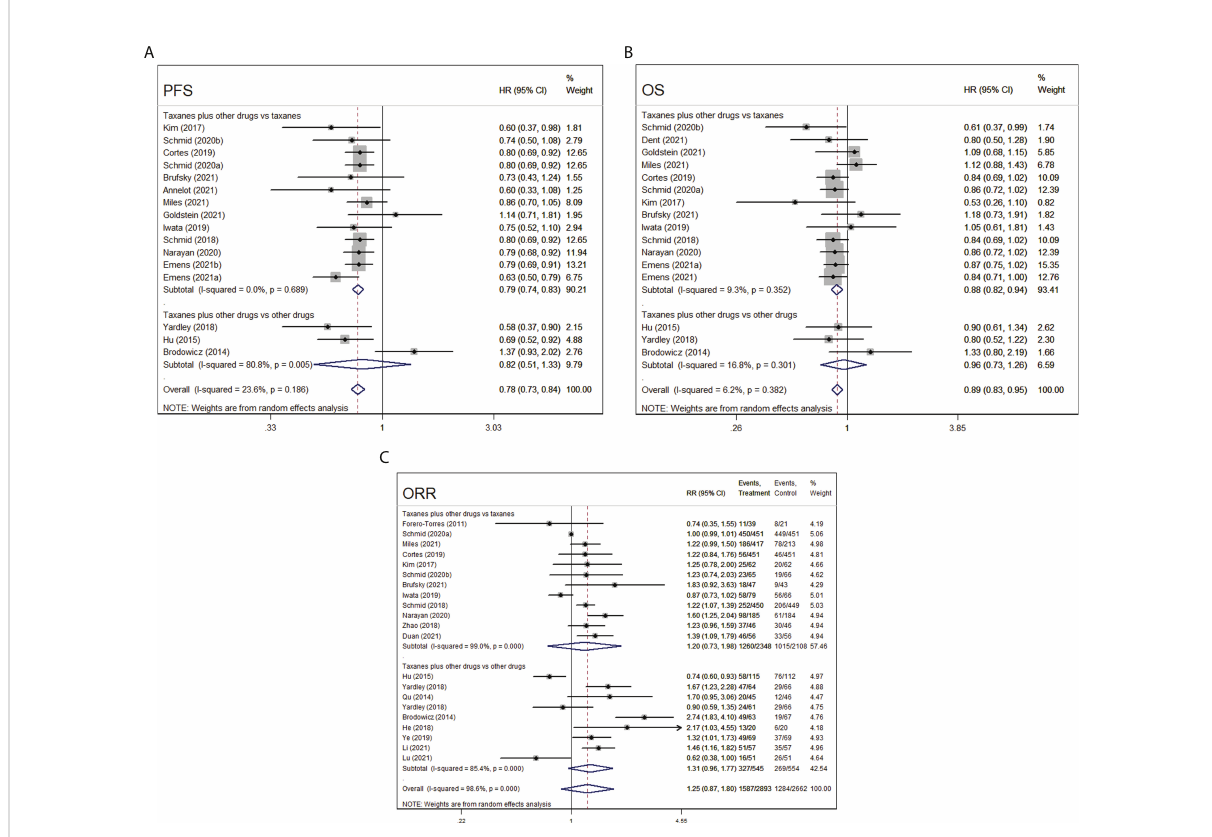
FIGURE 4 Forest plot of randomized controlled trials on taxanes combination therapy for primary outcomes: PFS (A) , OS (B) , and ORR (C)